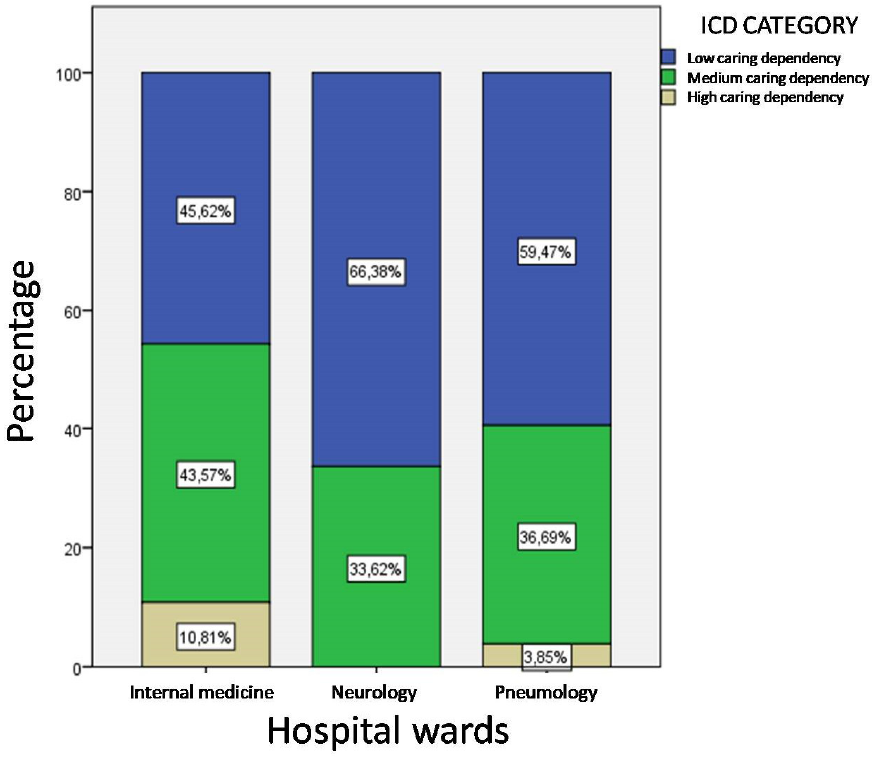
Figure 5. Distribution of levels of care dependence by hospital wards.